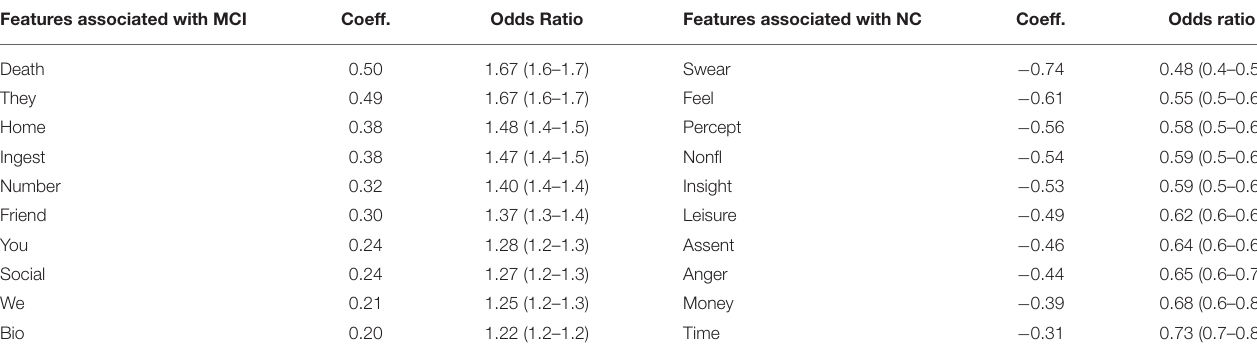
TABLE 3 | Top 10 LIWC feature coefficients correlated with MCI compared with top 10 coefficients correlated with NC. Features associated with MCI Coeff. Odds Ratio Features associated with NC Coeff. Odds